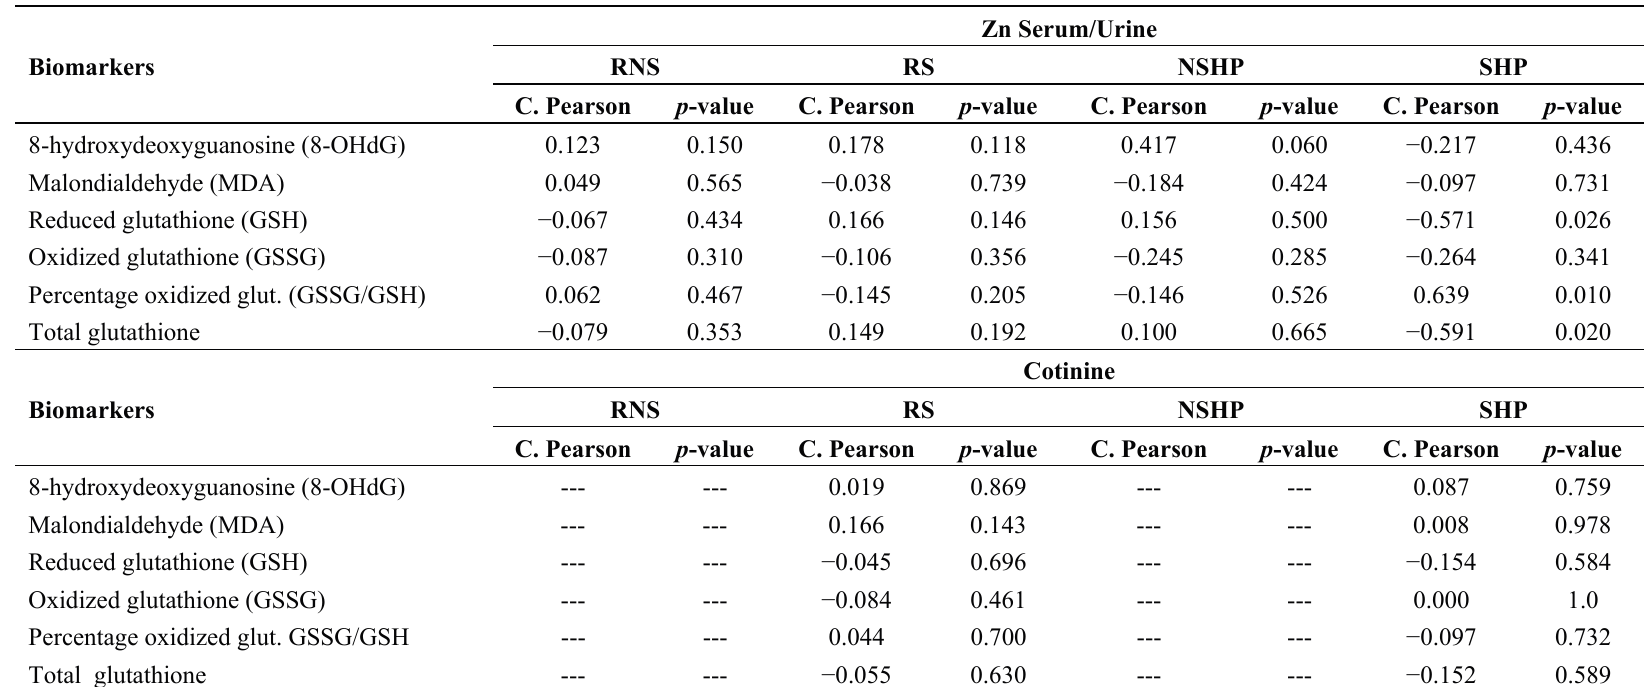
Table 4. Correlation between oxidative stress markers with zinc serum/urine quotients and cotinine levels.